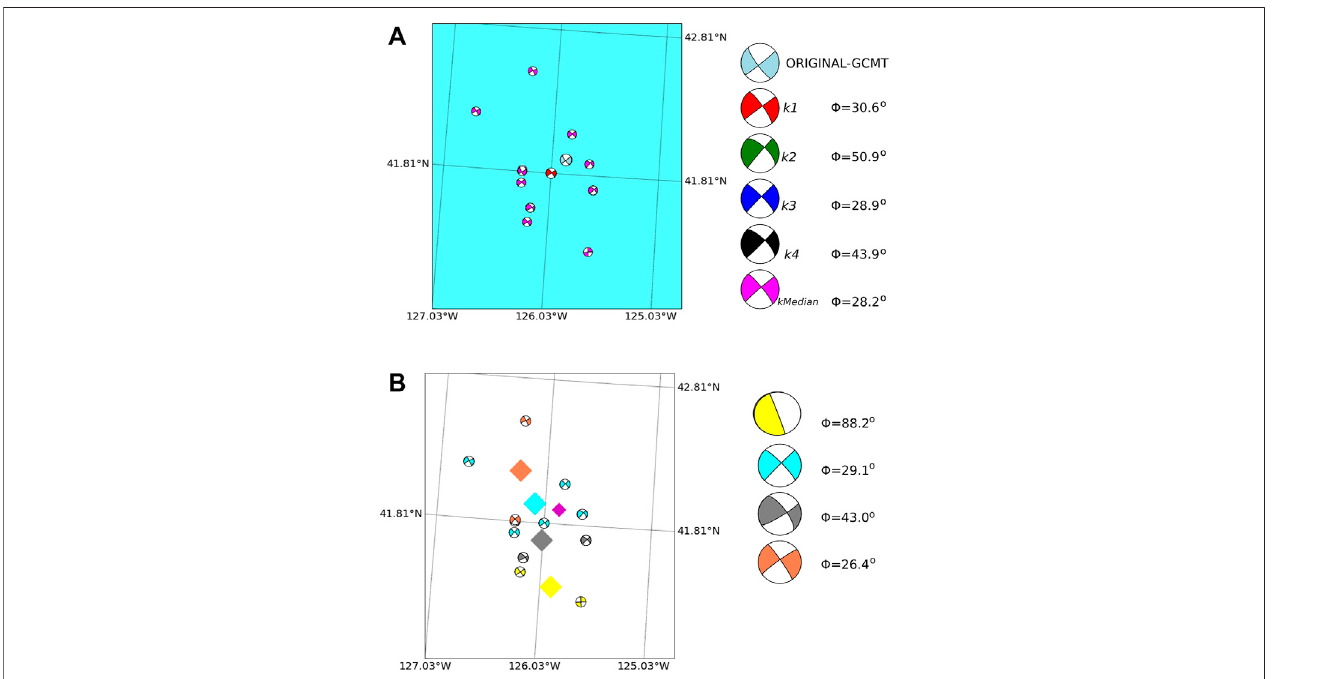
FIGURE 10 | Same as Figure 8 for an M w = 5.3 Californian earthquake (see Table 3 ).